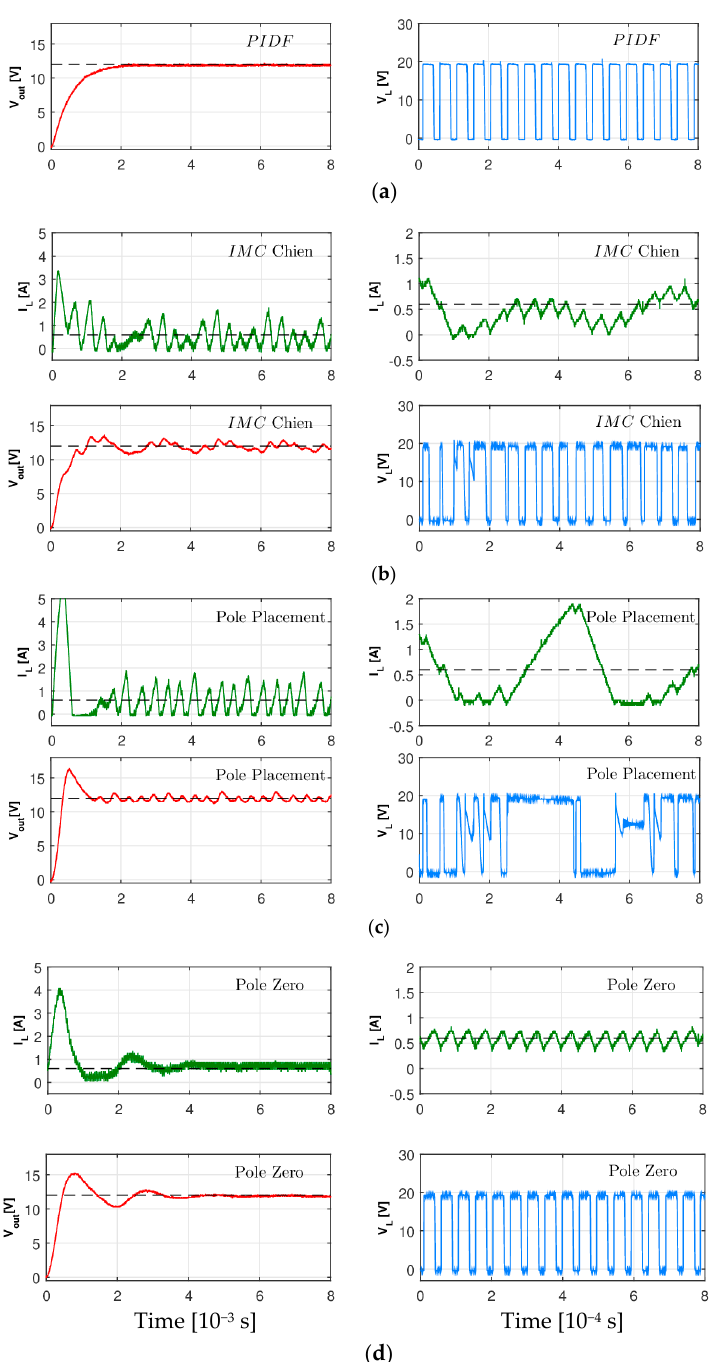
Figure 14. Inductor current and output voltage under step variation of reference value from 0 V to 12 V and zoom of inductor current and inductor current at steady-state using: ( a ) Inversion Formulae, ( b ) IMC-Chien, ( c ) Pole Placement, and ( d ) Pole Zero methods.